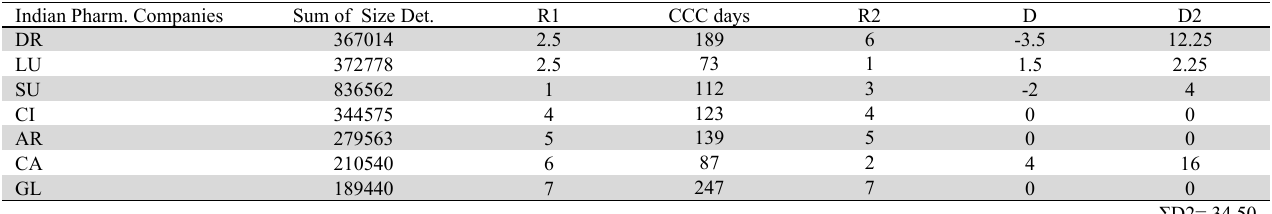
Relational co-movement of size and CCC Indian Pharm. Companies Sum of Size